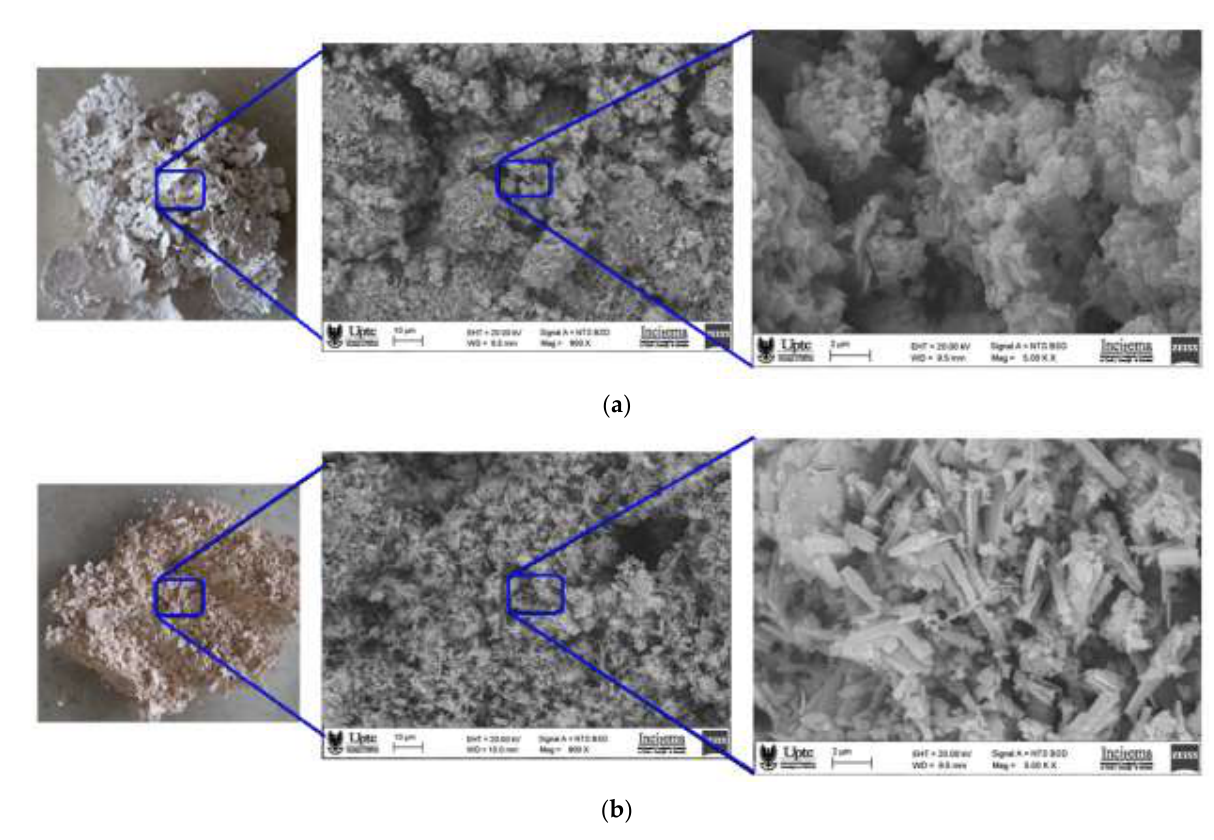
Figure 5. Macroscopic (left) and SEM (middle 800× and right 5000×) images of the dried flocs formed using biocoagulant ( a ) and chemical coagulant ( b ).